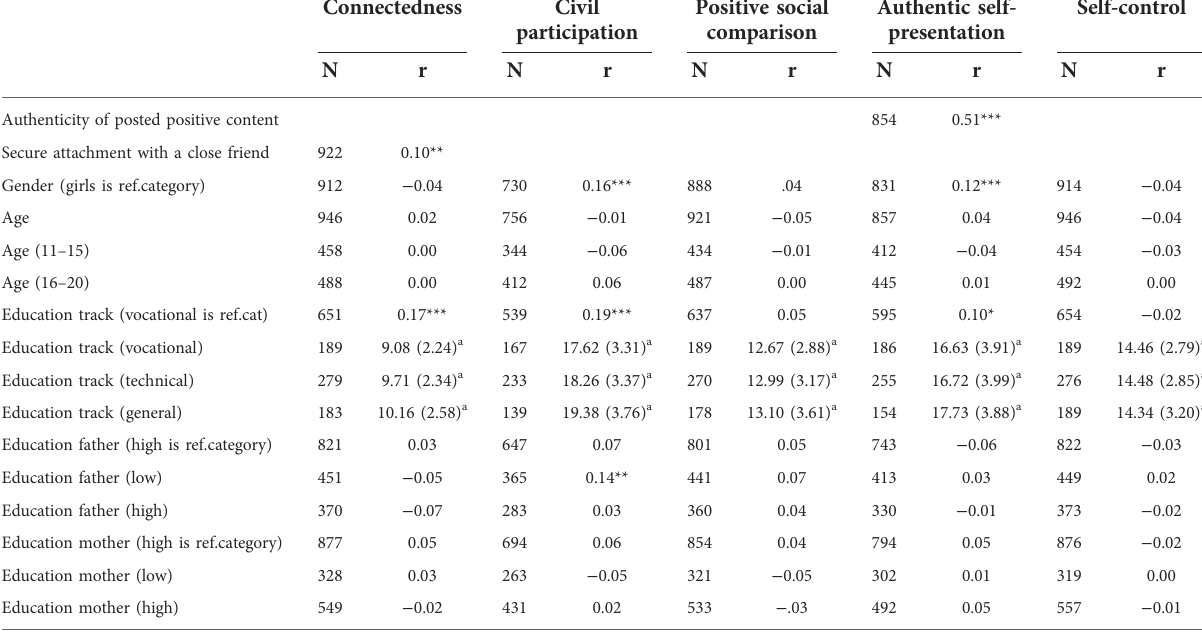
TABLE 3 DFSA construct validity and correlations with demographic statistics (study